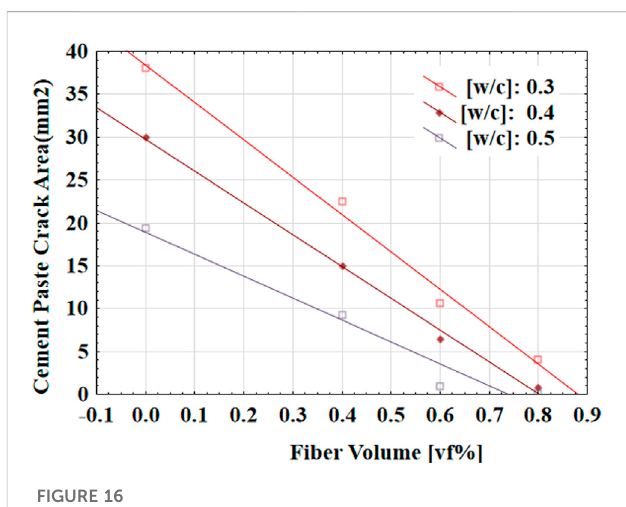
Cement-paste crack area against fi bre V f